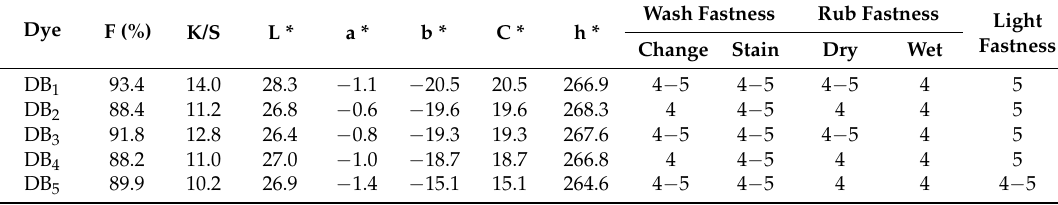
Table 1. Fixation and fastness properties of azo-anthraquinone reactive dyes on